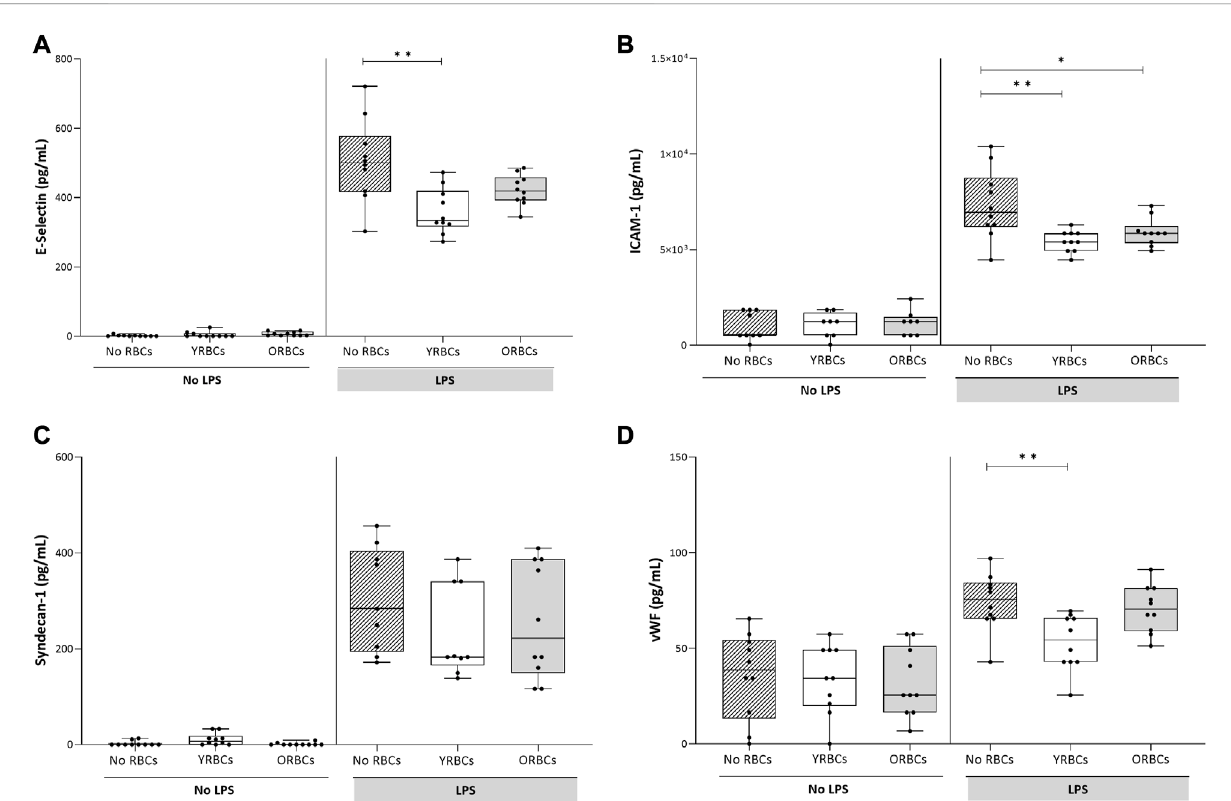
FIGURE 3 Endothelialactivationmarkersafterincubatingyoungredbloodcells(YRBCs)andoldredbloodcells(ORBCs)withendothelialcells.Concentrations of (A) E-selectin, (B) ICAM-1 (C) syndecan-1, and (D) Von Willebrand Factor were measured in presence and absence of LPS. * denotes a signi fi cant difference (* p-value < 0.05, ** p-value < 0.01, *** p-value < 0.001) when compared with no RBCs group. n = 9 – 10